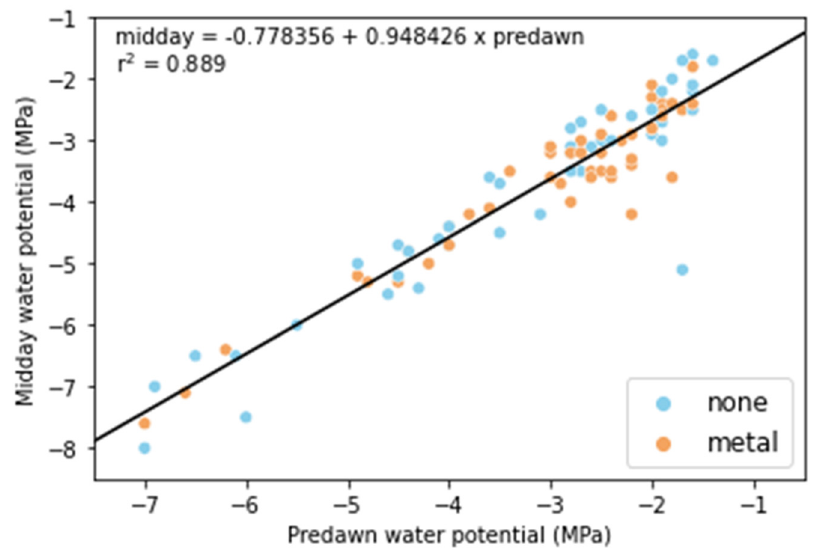
Figure 6. Relationship between predawn and midday water potential in Artemisia tridentata seedlings. Measurements were made during the first summer following the 2019 outplanting.